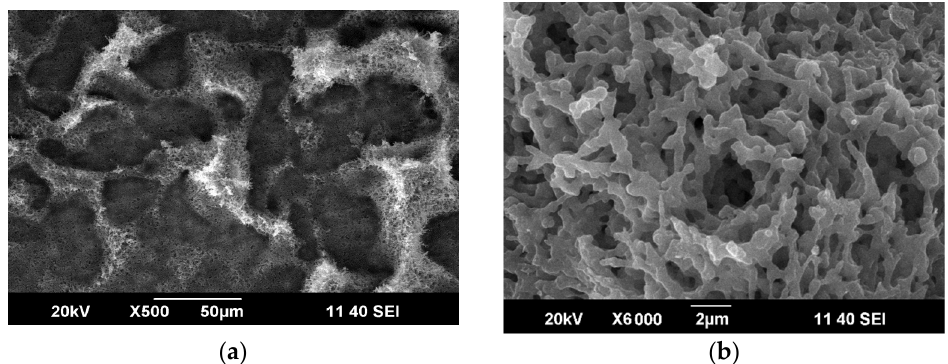
Figure 5. SEM images of the PC-carboxylated carbon nanotube (CNT) composite powder at 500× ( a ) and 6000× zoom ( b ).